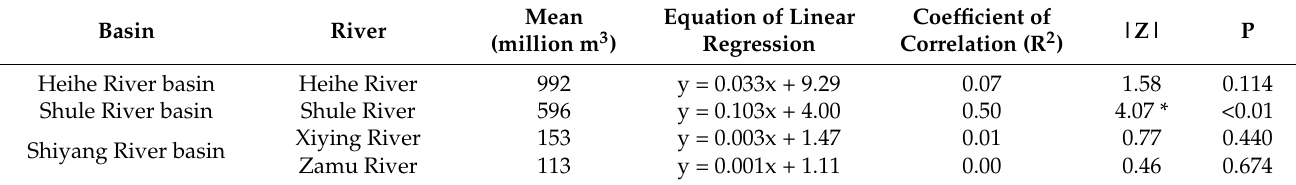
Figure 4. The trend of the inter-annual base flow in the Hexi inland rivers basin. Table 4. The inter-annual variability of the base flow in the Hexi inland rivers